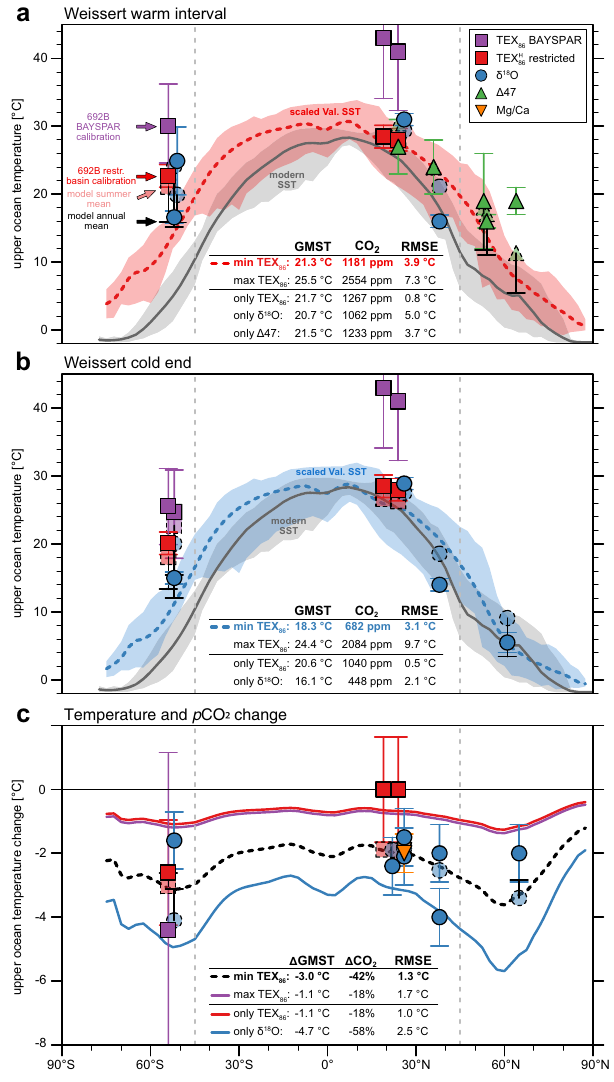
Fig. 4 Best- fi t model-proxy comparison of upper ocean temperatures and model CO 2 estimates. Estimates of global mean surface temperatures (GMSTs) and associated model CO 2 levels are calculated for the whole dataset as well as for three different subsampling experiments including only single proxy techniques (only-TEX 86 , only- δ 18 O and only- Δ 47). In addition, TEX 86 -derived temperatures are calculated from either the calibration for modern deep, restricted basins (min-TEX 86 ) or the BAYSPAR calibration (max-TEX 86 ) for DSDP/ODP sites 534, 603 and 692. Error bars document 90% con fi dence intervals for the TEX 86 calibration and uncertainties for other proxies as reported in Supplementary Table 1. a Model SSTs are linearly scaled to the best- fi t CO 2 estimate of 1181 ppm during the Weissert warm interval (see Supplementary Equation 5). Root- mean-square-error (RMSE) between scaled model temperatures and local proxy data are discussed in the Supplementary ‘ Global mean surface temperature and p CO2 estimates ’ section. Shading around the zonal mean shows the range of annual mean SSTs at each latitude, for modern 70 (grey) and Valanginian (red and blue). Dashed symbols represent simulated annual (summer) mean SSTs at low (high) latitude proxy locations for the derived mean CO 2 concentrations. Black bars show the difference between the warmest 3-months and annual mean temperature for high-latitude sites. b Model SSTs linearly scaled to the mean CO 2 estimates of 682 ppm during the Weissert cold end. c Model temperature and p CO 2 change from the Weissert warm interval to Weissert cold